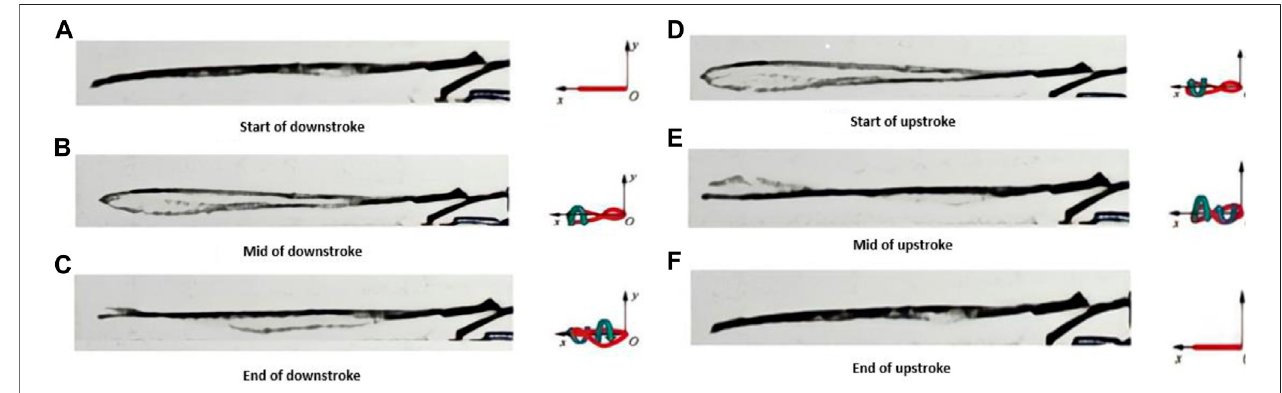
FIGURE 5 | Side view of the fl apping wing captured by high speed camera during one fl apping cycle at 30 Hz (A) Start of downstroke, (B) Mid of downstroke, (C) End of downstroke, (D) Start of upstroke, (E) Mid of upstroke, (F) End of